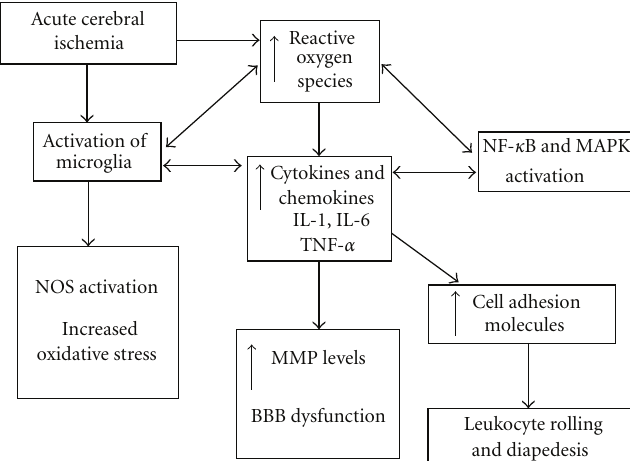
Figure 1: Acute cerebral ischemia and neuroinflammation. Acute stroke triggers an inflammatory cascade via the activation of a number of molecular mediators. The initial phase is associated with the generation of reactive oxygen species (ROS) within the ischaemic cerebral tissue. This is followed by the release of inflammatory cytokines and chemokines, which subsequently results in activation of resident microglia and upregulation of cell adhesion molecules (CAMs). The chemokines are involved in the mobilisation of leukocytes, and these inflammatory cells then interact with the CAMs. This leads to leukocyte infiltration of the ischaemic tissue (diapedesis), which further exacerbates the inflammatory process. Activation of nuclear factor kappa-B (NF- κ B) and inducible nitric oxide synthase (iNOS) results in increased oxidative stress and further cytokine activation. Release of matrix metalloproteinases (MMPs) from astrocytes and microglia leads to blood- brain barrier (BBB) dysfunction, cerebral oedema, and neuronal cell death. The aging process further exacerbates these neuroinflammatory pathways, and this has been associated with increased cognitive decline and poor functional outcome in elderly stroke patients. Therapeutic targeting of these molecular pathways is an important area of translational medicine research in cerebrovascular